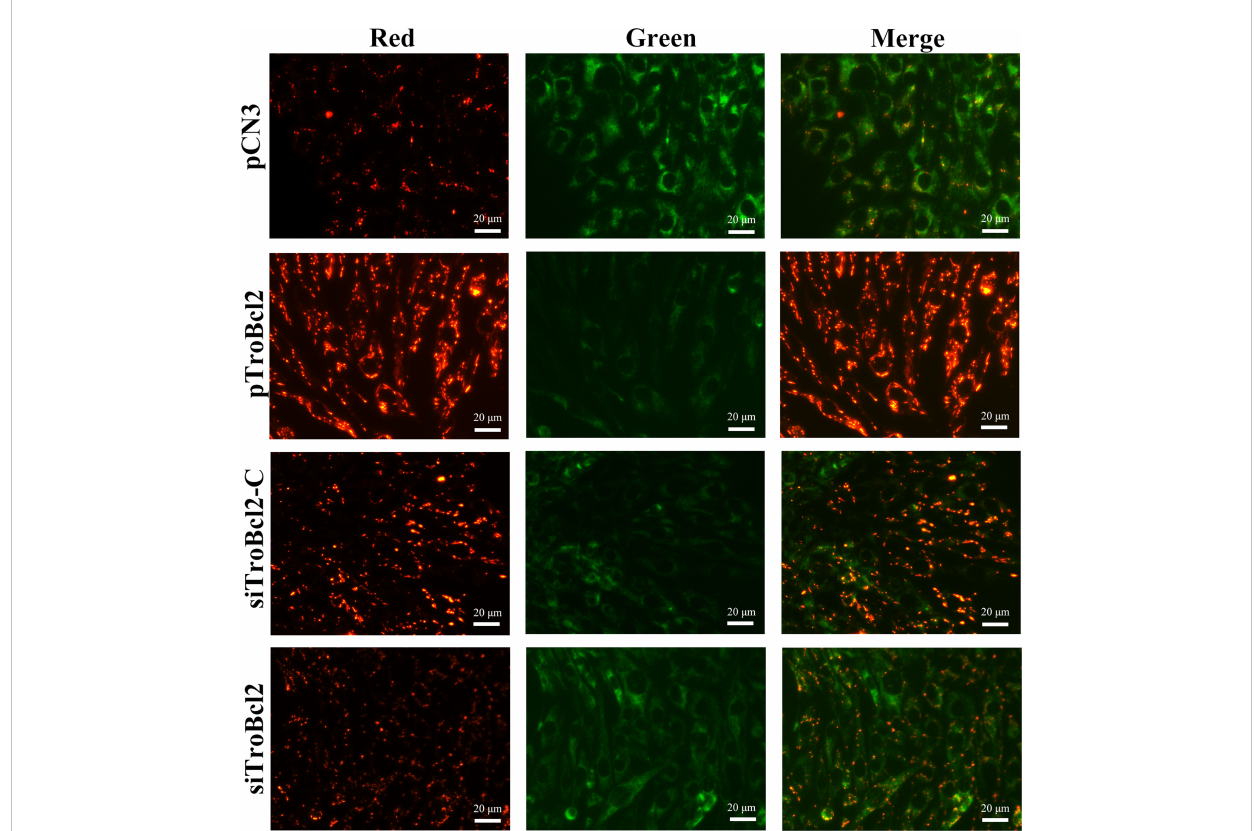
FIGURE 5 Effect of TroBcl2 overexpression and knockdown on mitochondrial membrane potential (MMP) upon LPS stimulation. GPS cells were transfected with pTroBcl2, pCN3, siTroBcl2, or siTroBcl2-C. Following 24 h transfection, cells were treated with LPS and the MMP change was measured by enhanced mitochondrial membrane potential assay kit with JC-1. The red and green fl uorescences were observed by inverted fl uorescence microscope